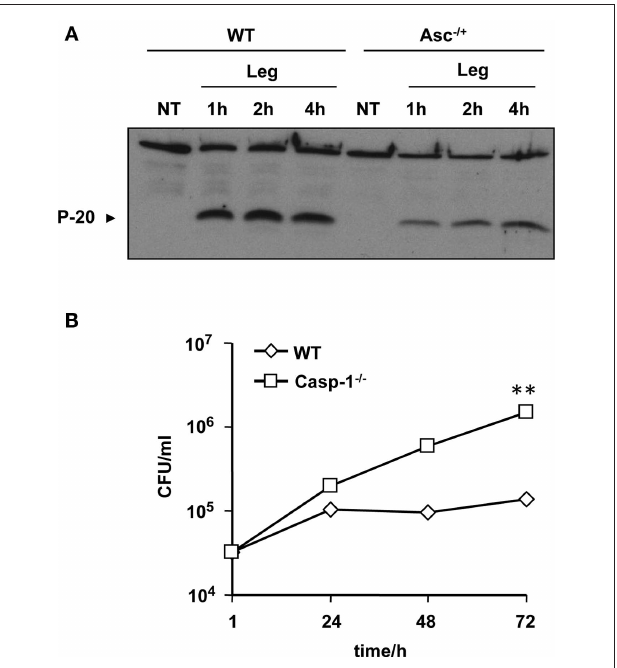
Figure A1 | (A) Wild type (WT) mouse macrophages and heterozygous Asc (Asc − / + ) were infected or not (NT) with L. pneumophila (Leg) at MOI = 0.5 for 1, 2, and 4 h. Total active caspase-1 (p-20) was detected in combined lysate and supernatants by Western blotting. (B) WT and caspase-1 − / − macrophages were infected with L. pneumophila (Leg) at MOI = 0.1 and the bacterial replication was assessed by counting the colony-forming units (CFU) after 1, 24, 48, and 72 h. Results are displayed as mean ± SD of three independent wells. ** P ≤